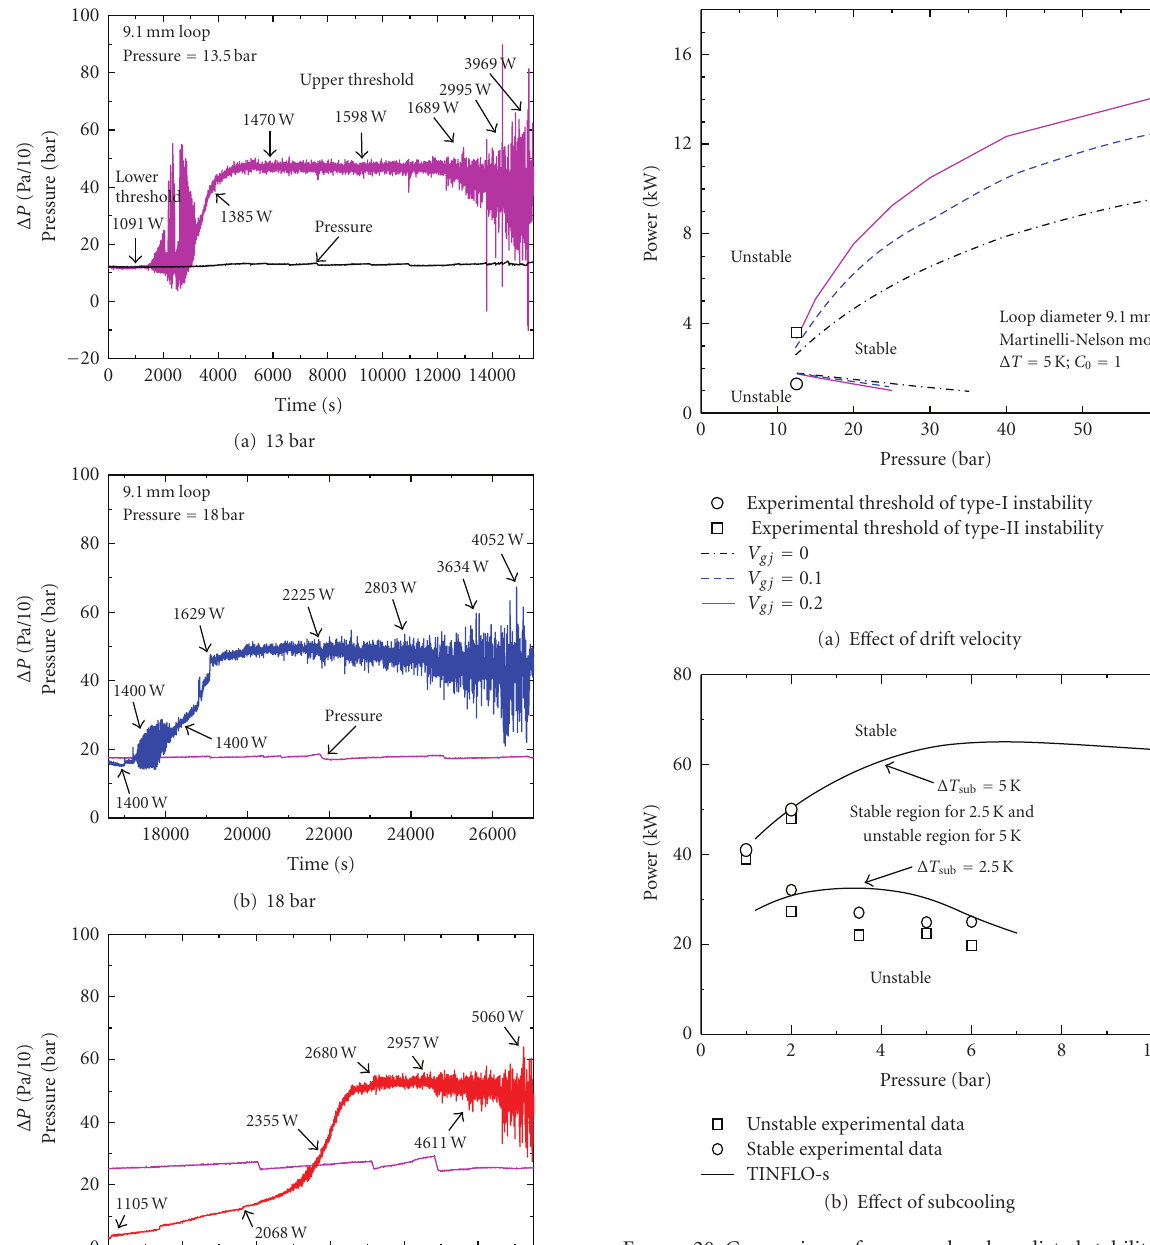
Figure 22(c), stability-controlled design is found on the right of the dotted line.